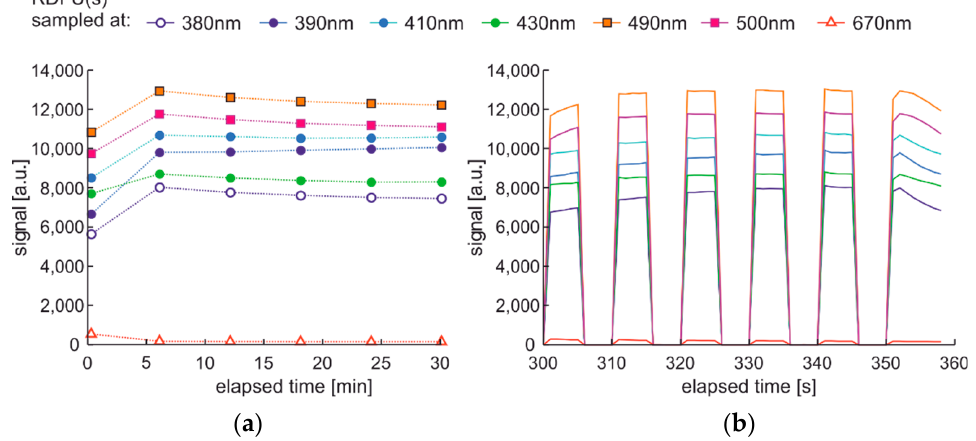
Figure 25. Time series of fluorescence data of regular diesel RDFU(s) in cycle DME:UVonTon: ( a ) full-time series; ( b ) zoom of the initial pack.